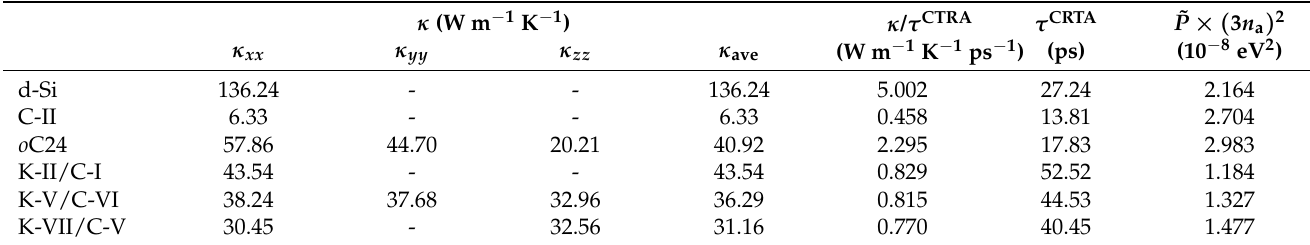
Table 5. Calculated lattice thermal conductivity of the six structures examined in this work at T = 300 K. For each structure the unique diagonal components κ xx , κ yy and κ zz of the κ latt tensor, corresponding to transport along the Cartesian x , y and z directions, are shown together with the average κ ave defined in Equation (15). Decompositions of the κ ave into a harmonic term κ / τ CRTA and lifetime term τ CRTA as defined in Equation (16) are also shown, together with the scaled averaged three-phonon iteraction strengths ˜ P defined in Equation